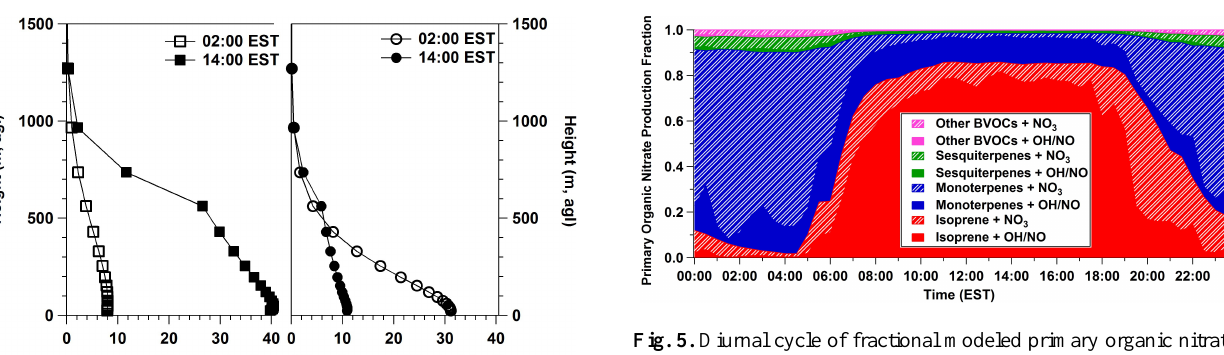
Fig. 5. Diurnal cycle of fractional modeled primary organic nitrate production at ∼ 12m above the forest canopy. Results for the base BVOC production rate scenario are